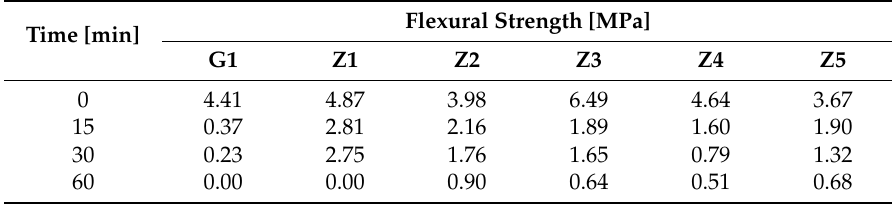
Figure 7. Flexural strength in time function. Table 9. Flexural strength in time